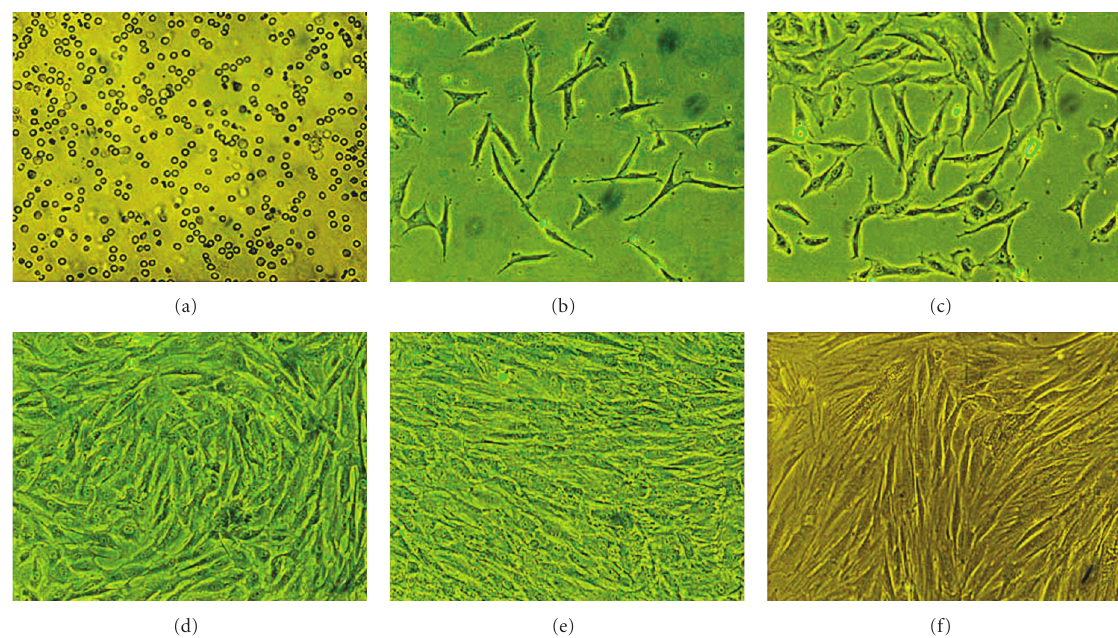
Figure 3: Morphology of MSCs in primary culture (100 × ). The primary cultured cells floated in medium and had a uniformed globular shape (a). 3-4 days later, the cells adhered to the bottle began division growth (b) and the proliferated cell had a long fusiform shape containing 1–3 nucleolus 5-6 days later (c). The cell colony can be seen 7–9 days later (d) and contact inhibition can be observed 10–12 days later (e). The 3rd generation MSCs was well-distributed as fibroblast.